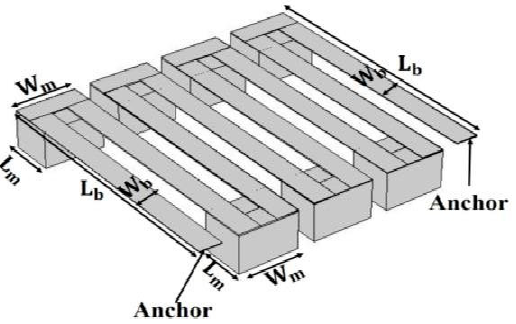
Figure 1. Structural diagram of the proposed low-resonant-frequency piezoelectric MEMS energy